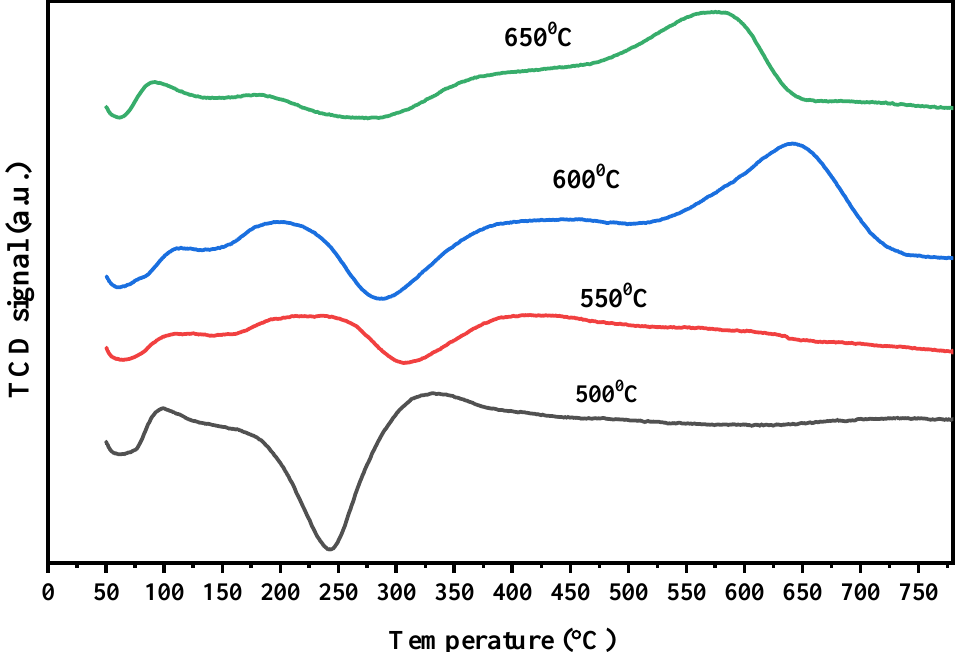
Figure 12. TPO profiles of the Ni-Al-H-600 catalyst after 7 h reaction temperature operated at different values (500, 550, 600, and 650 °C).